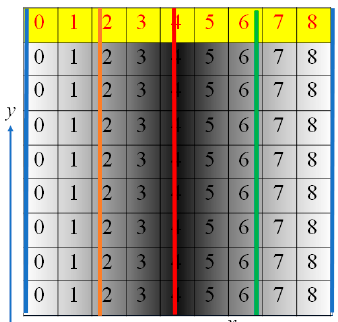
Figure 4. Brightness distribution and phase distribution for OPPA1 [17] (Blue, brown, red and green lines show phases of 0, 90, 180 and 270 degrees, respectively).